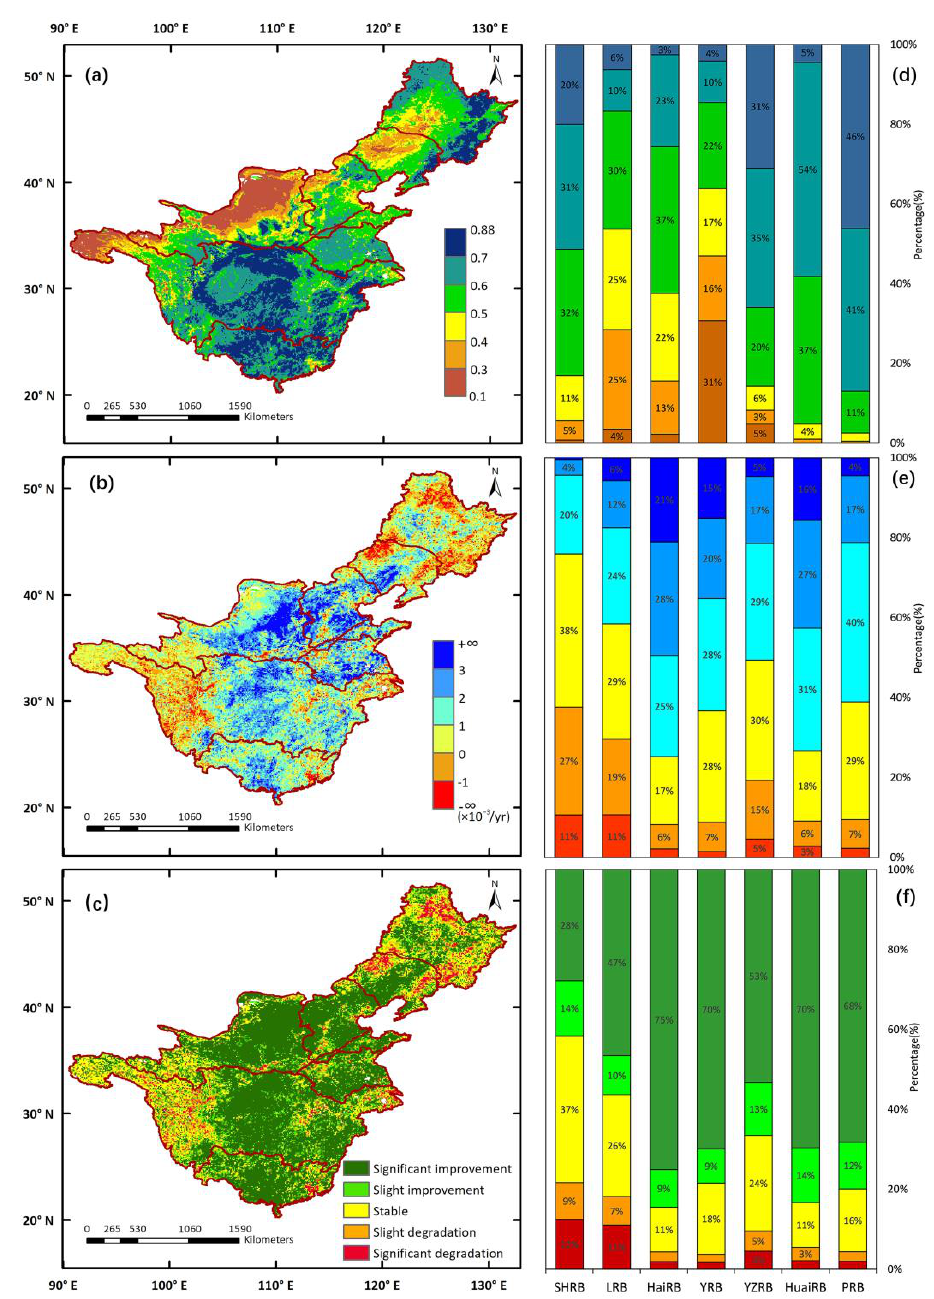
Figure 2. The spatial distribution of ( a ) mean annual growing season NDVI (GS-NDVI), ( b ) trends of GS-NDVI, ( c ) change degrees of GS-NDVI in seven major watersheds during 1982–2015, and the percentage distribution of ( d ) mean annual GS-NDVI, ( e ) trends, and ( f ) change degrees in each watershed.